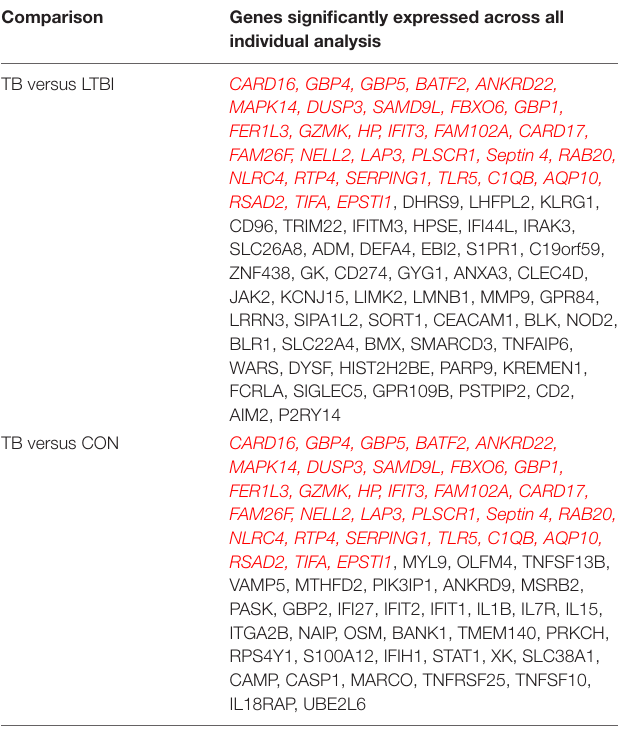
TABLE 3 | Genes differentially regulated across all studies in the study specific analyses.